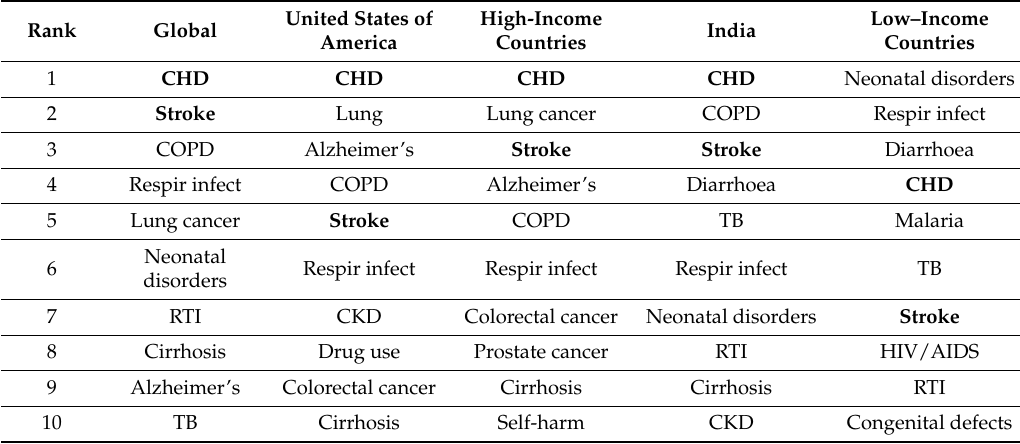
Table 3. The 10 most common causes of death in men, globally and in selected countries and regions, 2017.